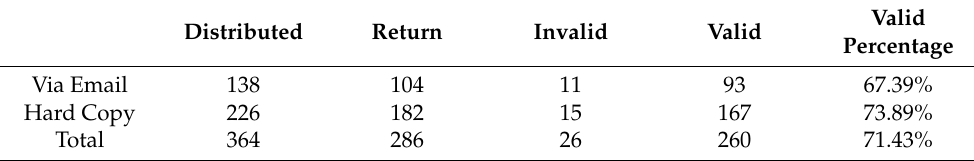
Table A3. Questionnaire distribution and